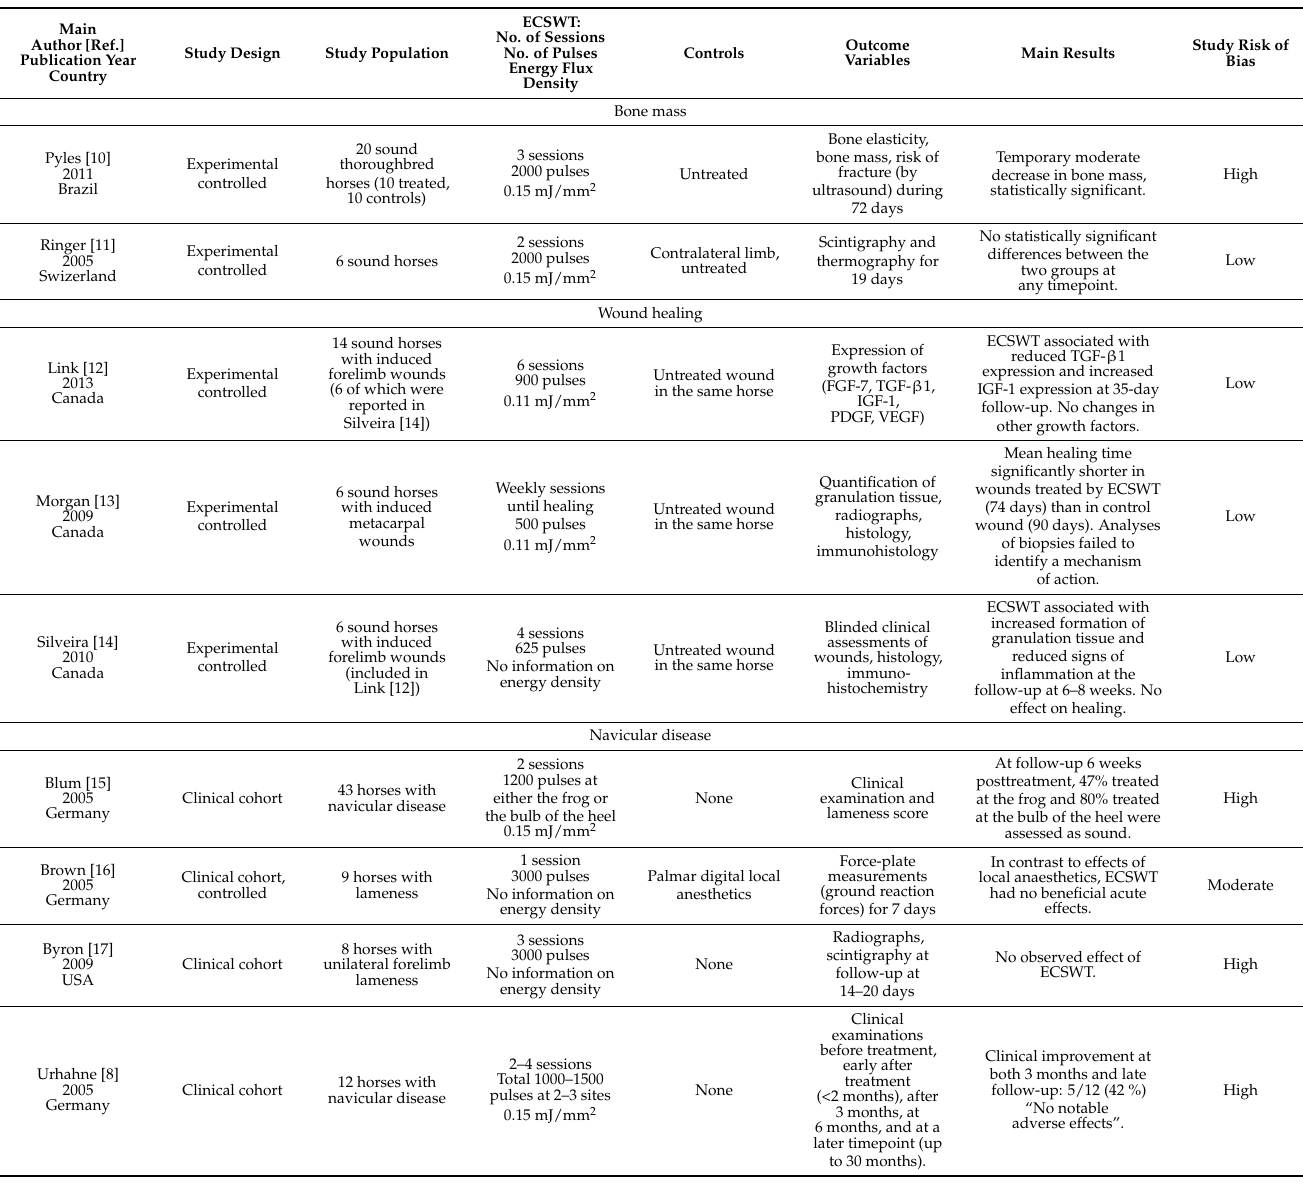
Table 1. ECSWT in horses: Characteristics of studies included in the systematic review.